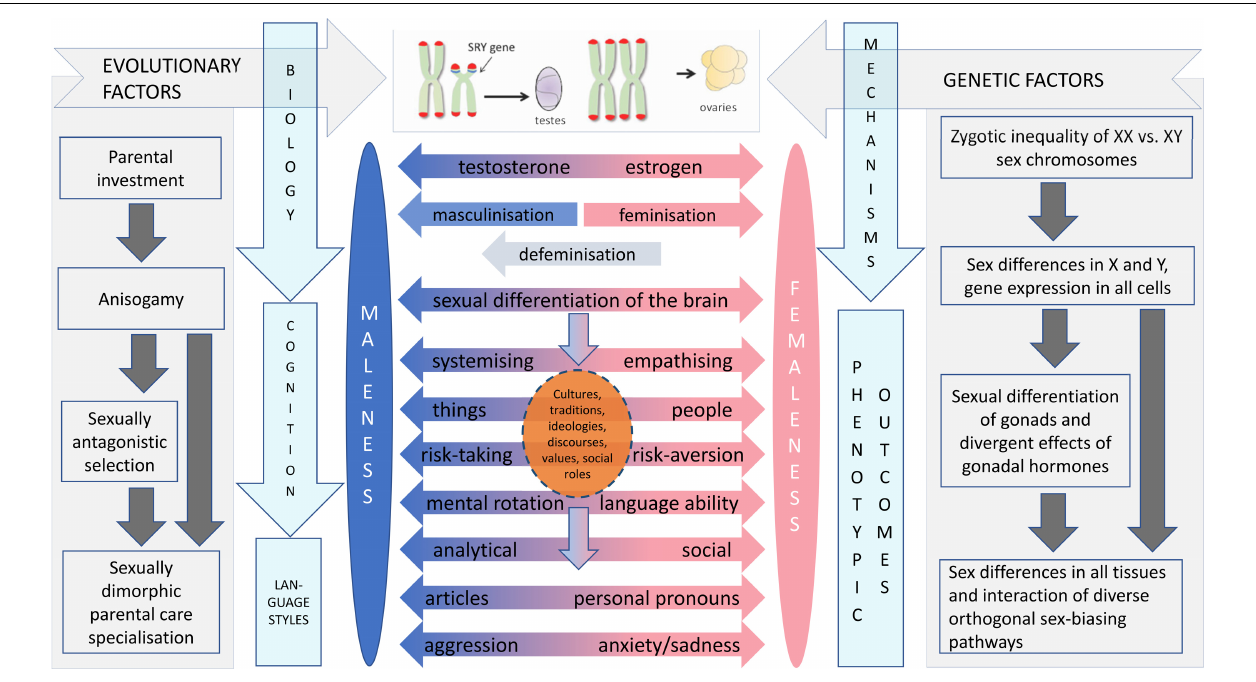
FIGURE 7 | The evolutionary–developmental origins and proximate mechanisms underlying psychobehavioural sex differences, including those in language use. Figure adapted from Luoto and Varella